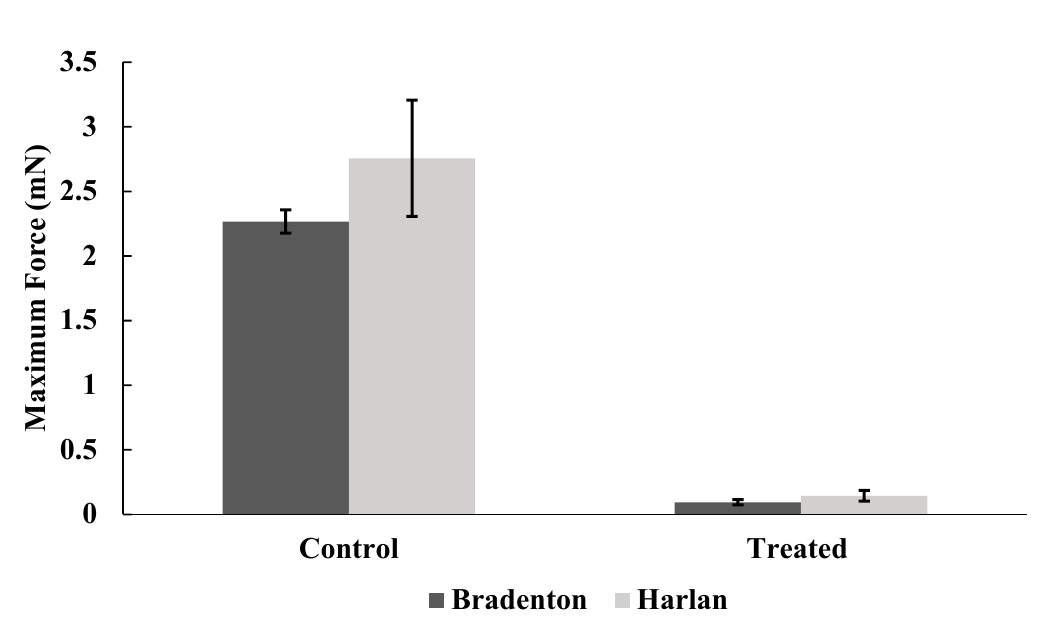
Figure 6. Maximum amount of force generated by Bradenton and Harlan strain bed bugs when gripping a surface with tarsi following no exposure to lufenuron (Control) or exposure to sub-lethal doses of lufenuron (Treated).